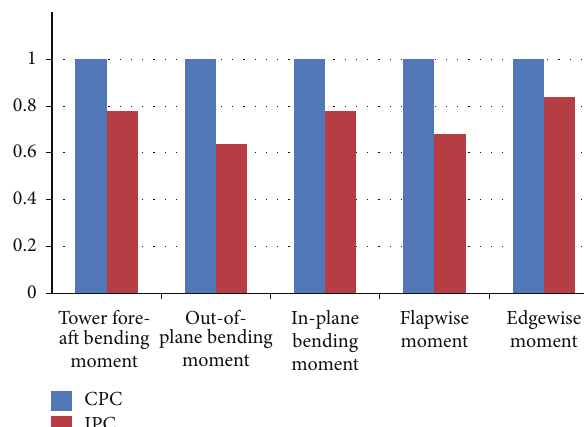
Figure 13: Fatigue loads comparison between CPC and